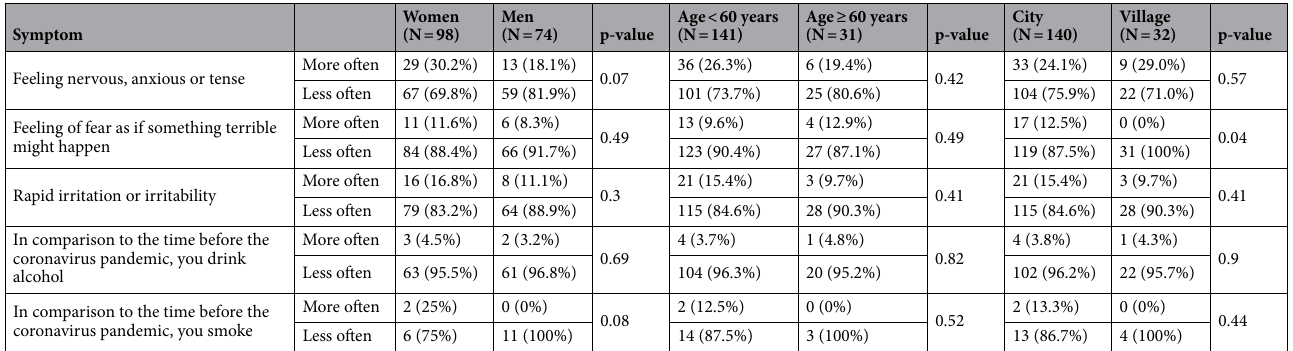
Table 3. Comparison of selected psychological parameters in patients who have experienced symptomatic COVID-19 (Group I) when considering the sex, age and place of living.